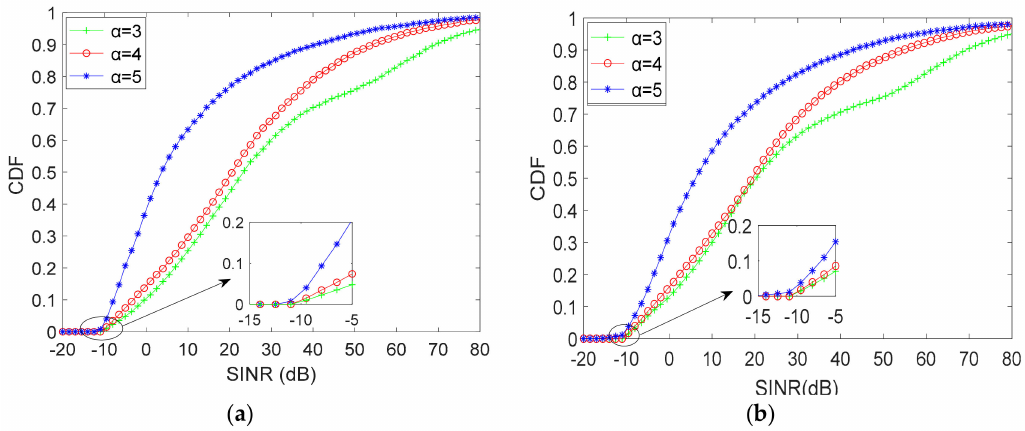
Figure 4. SINR of CUs for proposed WE-I-A algorithm: ( a ) N = 8, M = 10 and ( b ) N = 16, M =